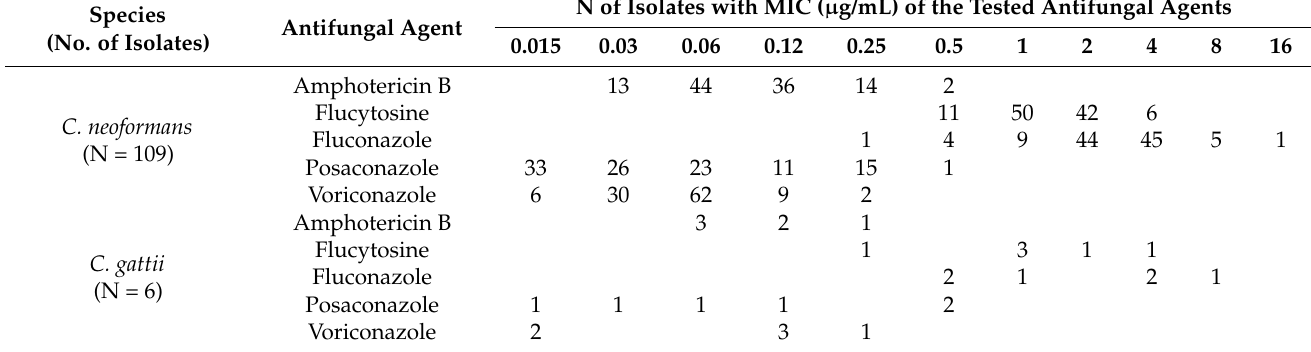
Table 2. Distribution of the MIC values using CLSI broth microdilution for clinical strains of Crypto- coccus neoformans and C. gattii .